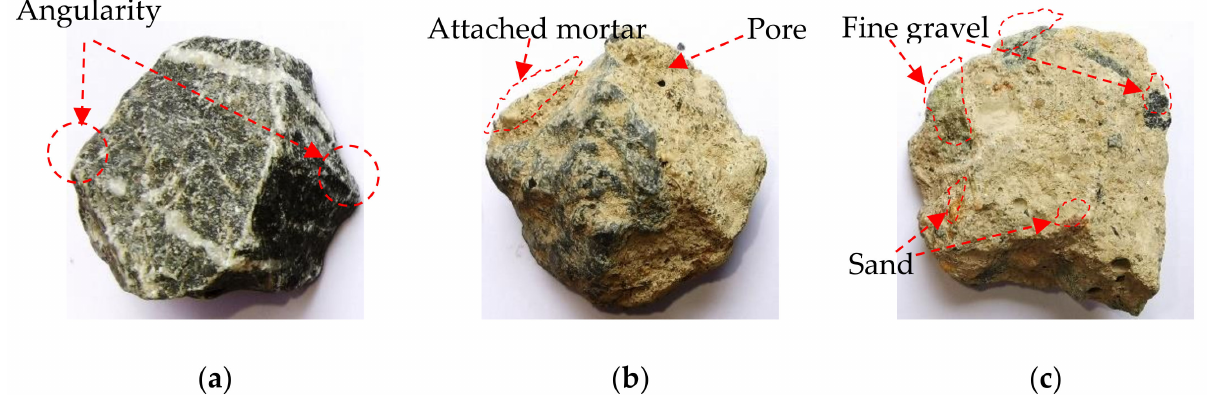
Figure 2. Appearance morphology of natural coarse aggregate and coarse recycled concrete aggregate: ( a ) natural coarse aggregate; ( b ) coarse recycled concrete aggregate; and ( c ) mortar block. Table 1. Physical properties of natural coarse aggregates (NCAs) and coarse recycled concrete aggregates (CRCAs). Aggregate Type